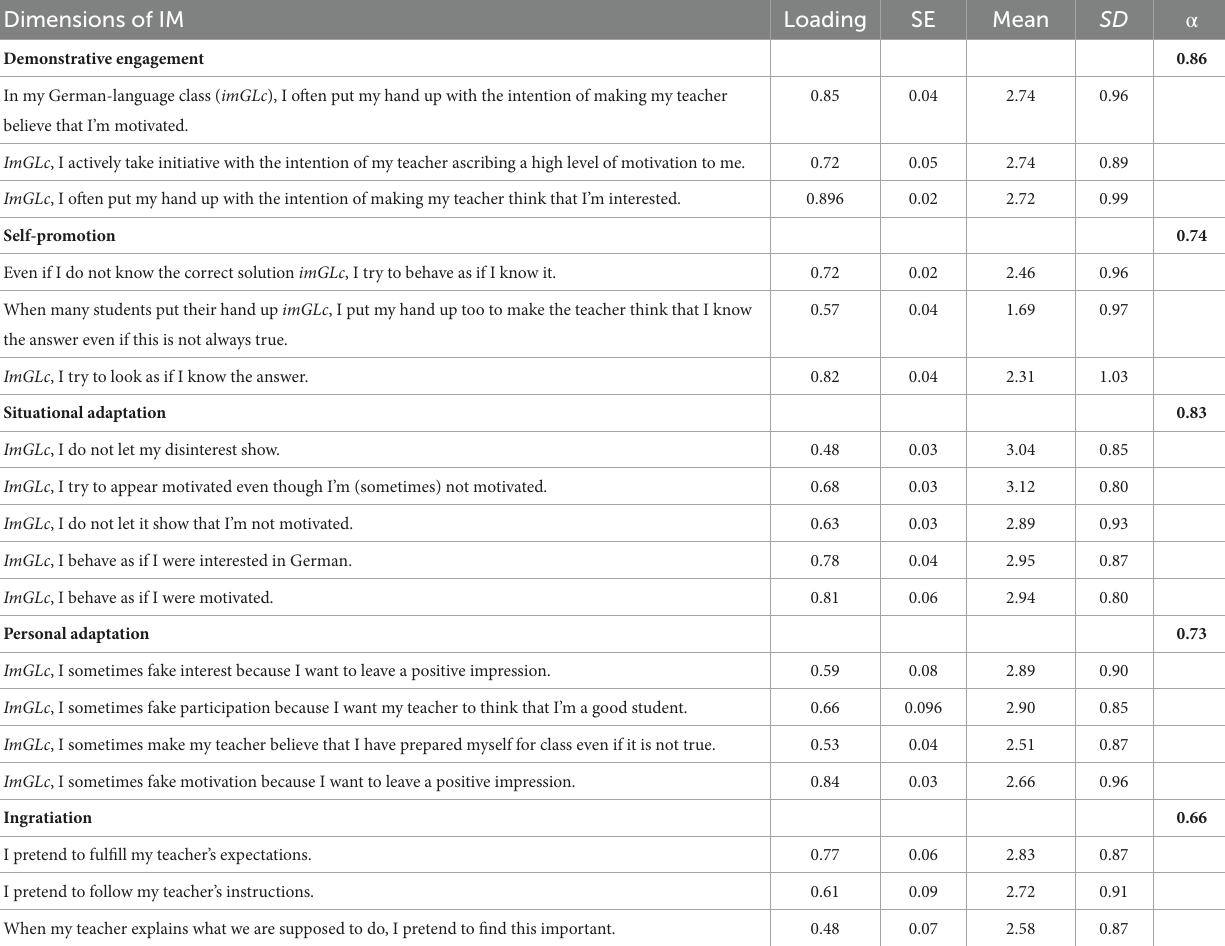
TABLE 1 Values resulting from the latent structural equation model of the five-dimensional structure of impression management. Dimensions of